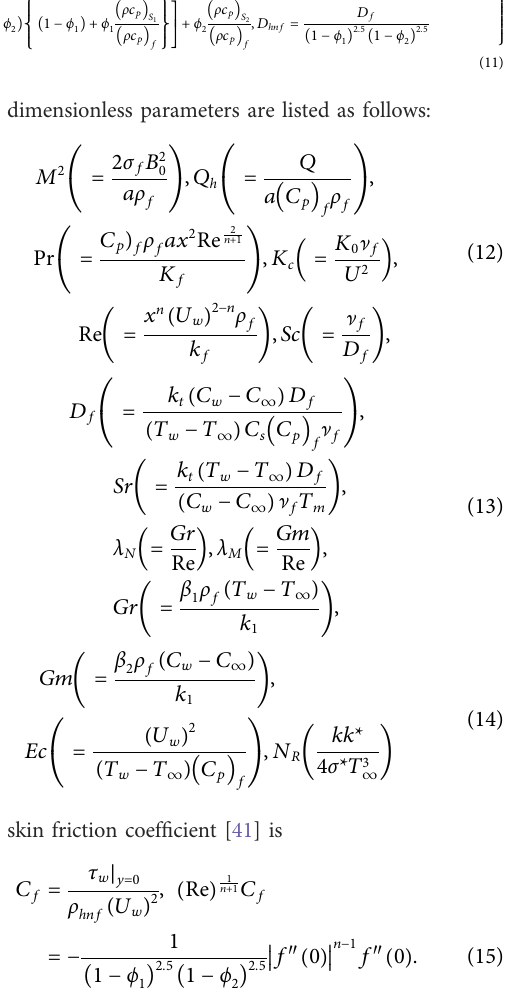
FIGURE 2 Illustration of FEM ( fi nite element method)